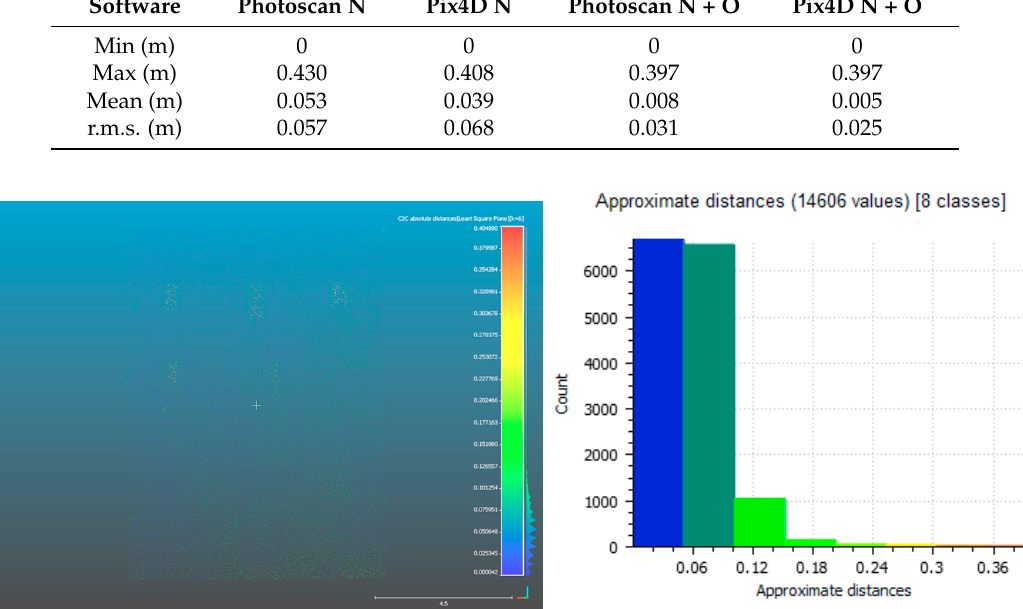
Figure 26. Discrepancy map and histogram between the TLS cloud and UAV Nadir in Pix4D. Figure 27. Discrepancy map and histogram between the TLS cloud and UAV Nadir + Oblique in Photoscan.